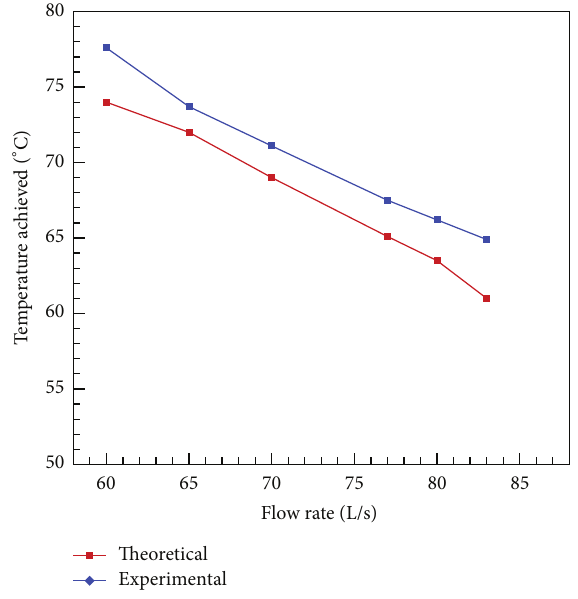
Figure 9: Flow rate versus outlet